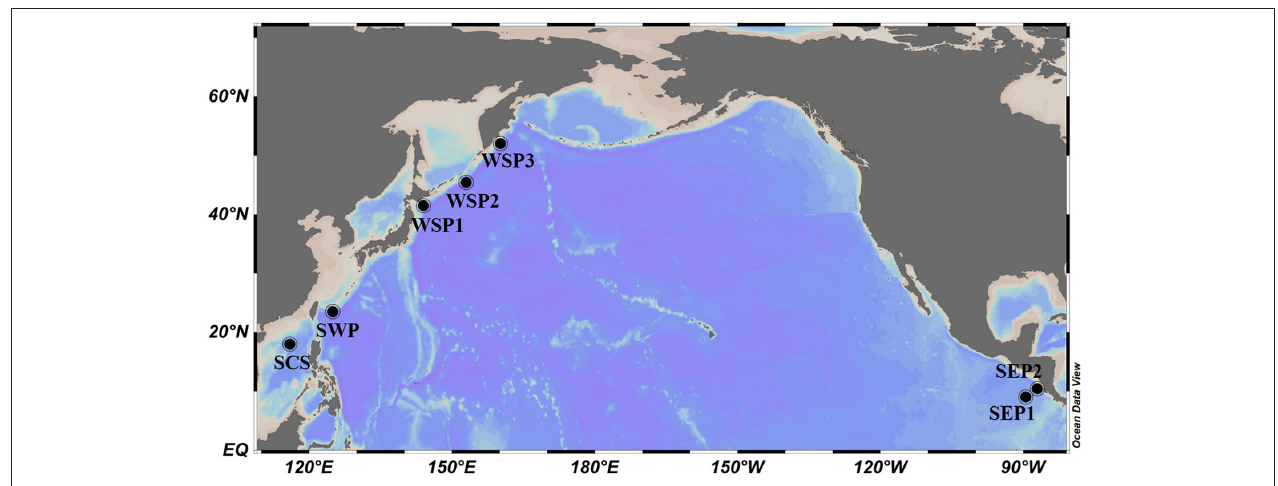
FIGURE 1 | Sketch map showing the various sampling locations. SCS, South China Sea; SWP, Subtropical Western Pacific-Station; SEP, Subtropical Eastern Pacific; WSP, Western Subarctic